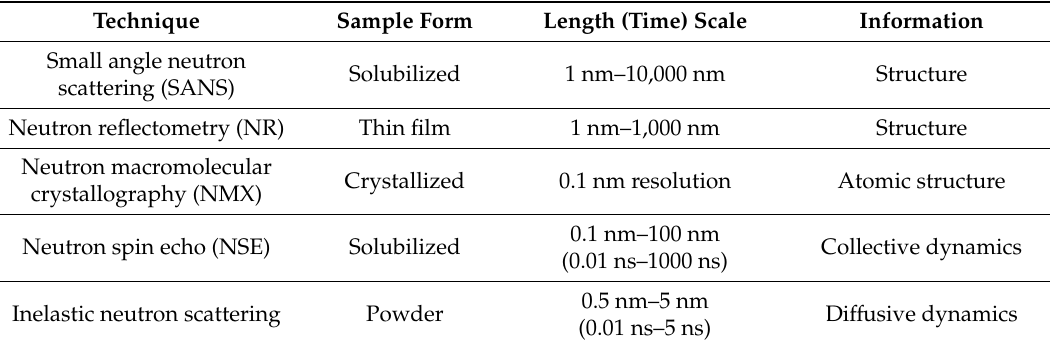
Table 1. Suite of neutron scattering techniques for probing biological materials.